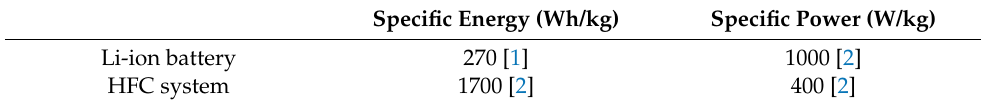
Table 1. Specific energy and specific power comparison of Li-ion batteries and HFC systems.